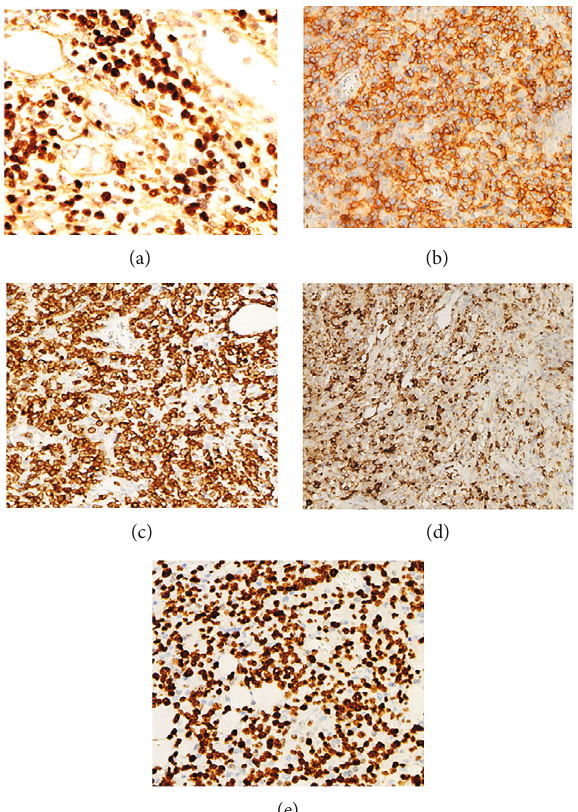
Figure 3: Immunohistochemical results (EnVision method, original magni fi cation 200x) of extranodal NK/T cell lymphoma, nasal type (ENKTCL): (a) EBER-positive oncocytes; (b – e) CD56, CD3, GrB, and Ki67 expression on oncocytes. EBER: Epstein – Barr virus-encoded RNA.